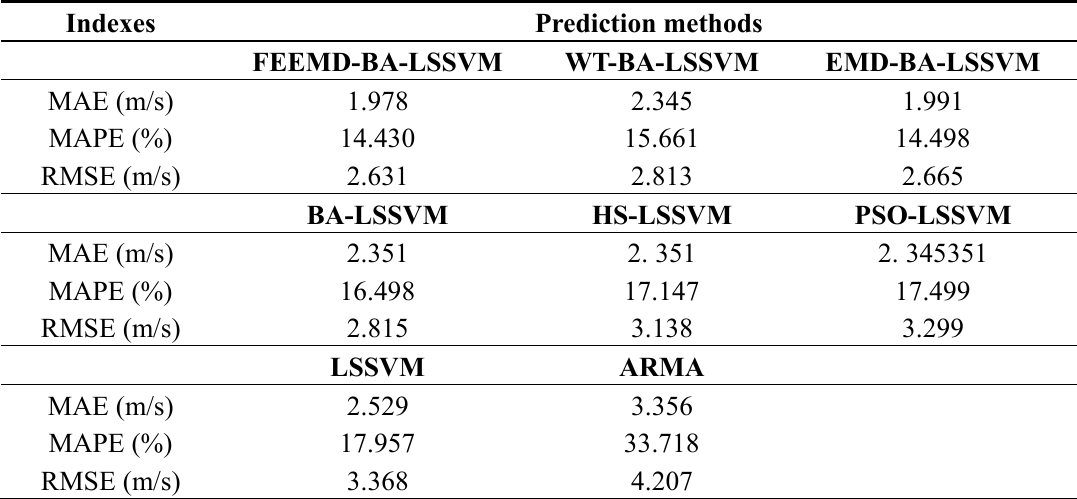
Table 10. Analysis of the predictions without temperature as